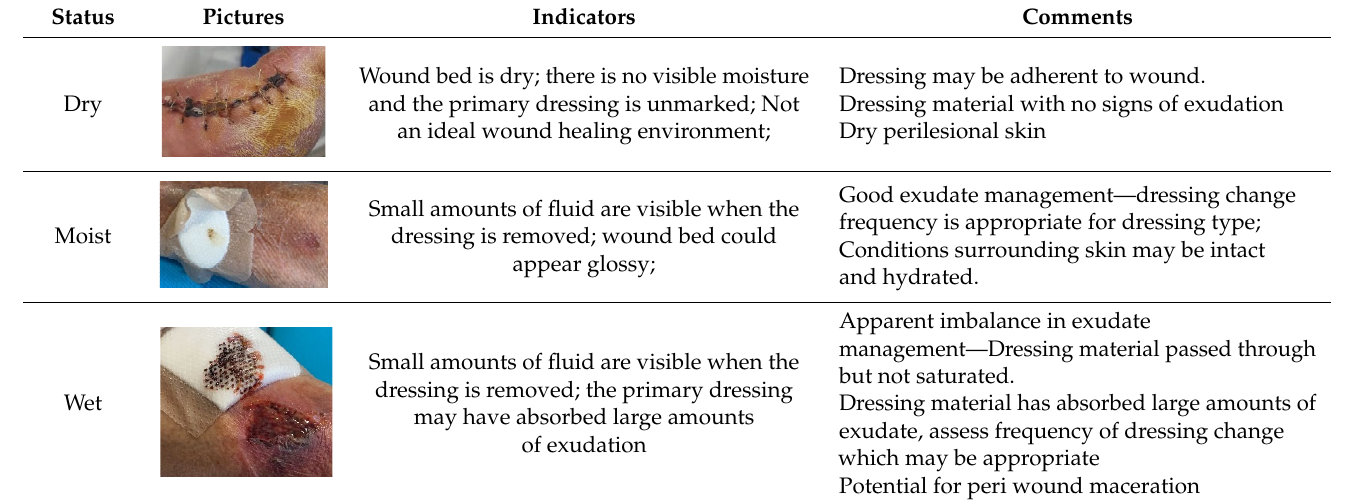
Table 3. Dressing ‐ exudate interaction